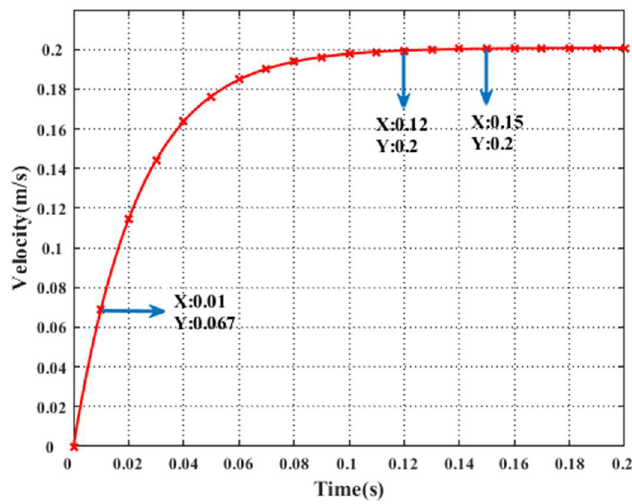
Figure 7. Velocity of a copper particle with a diameter of 1000 μm.